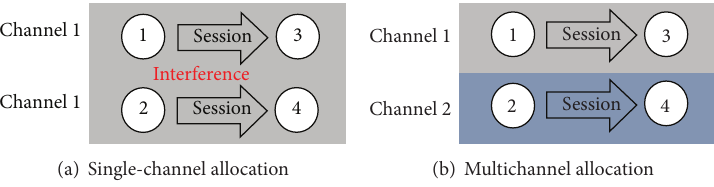
Figure 2: Difference between single-channel and multichannel